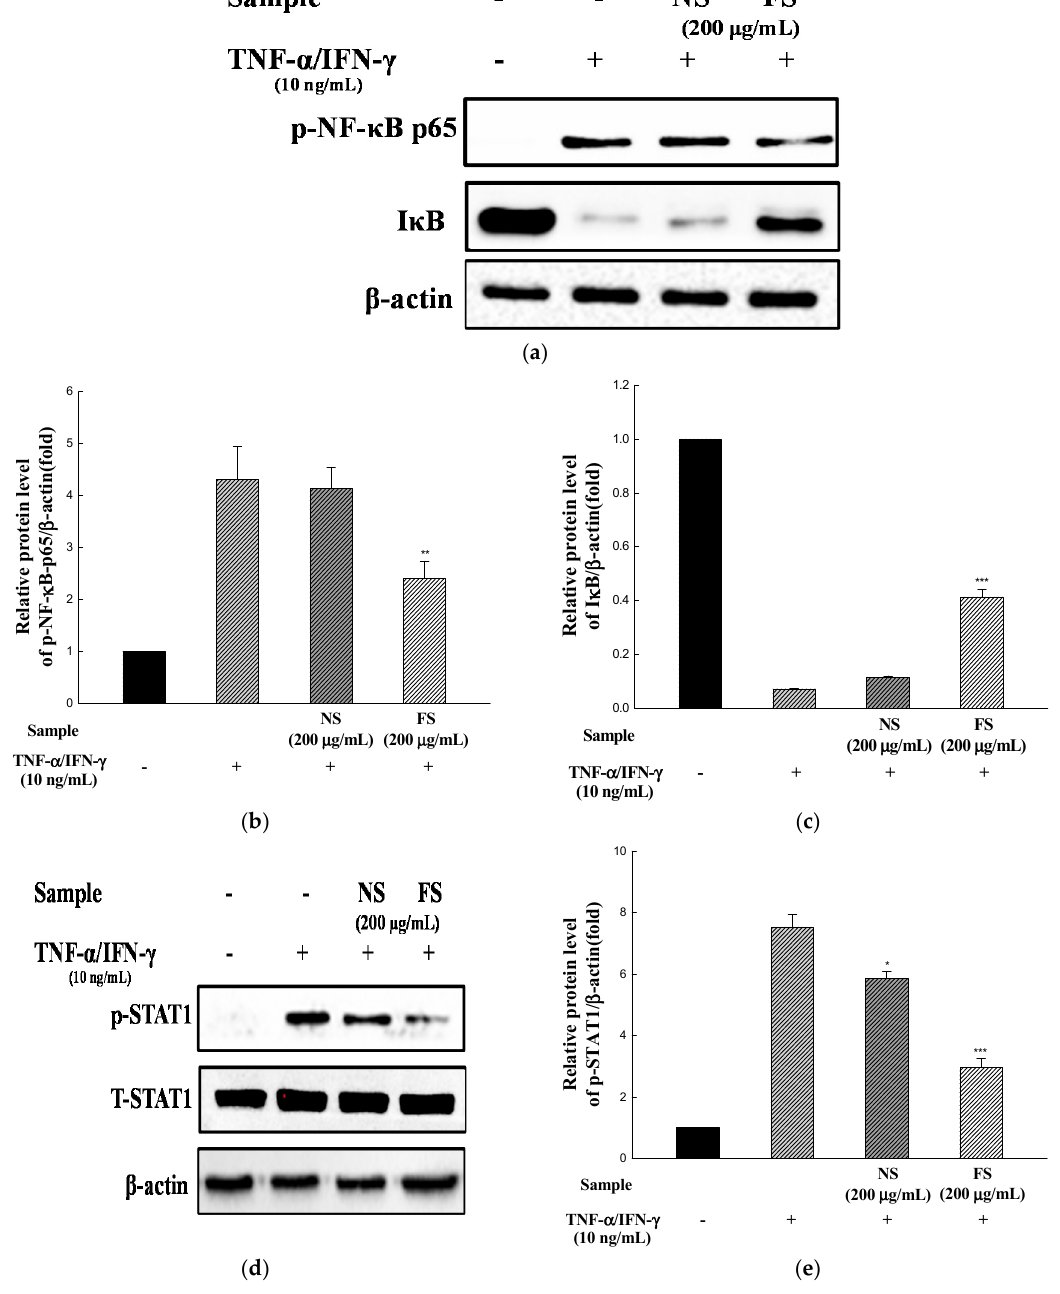
Figure 5. Effects of NS and FS extracts on TNF- α /IFN- γ -induced NF- κ B and STAT1 activation in HaCaT cells. Total protein expression and phospho-NF- κ B and I κ B were examined by western blot ( a ); The relative protein level was calculated for the p-NF- κ B/ β -actin ( b ); The relative protein level was calculated for the I κ B/ β -actin ( c ); Total protein expression and phosphorylation of STAT1 were examined by western blot ( d ) and the relative protein level was calculated for p-STAT1/ β -actin ( e ). Each bar represents the mean ± SD of triplicate determinations, n = 3; * p < 0.05, ** p < 0.01, *** p < 0.001 vs. TNF- α /IFN- γ treatment alone. +, TNF- α /IFN- γ treatment; − , TNF- α /IFN- γ untreated. TARC and MDC promoters contain STAT1 and NF- κ B-binding sequences and these transcription factors may mediate the transcription of these genes [27]. NF- κ B is a transcription factor that regulates the transcription of genes that are important in the occurrence of inflammatory